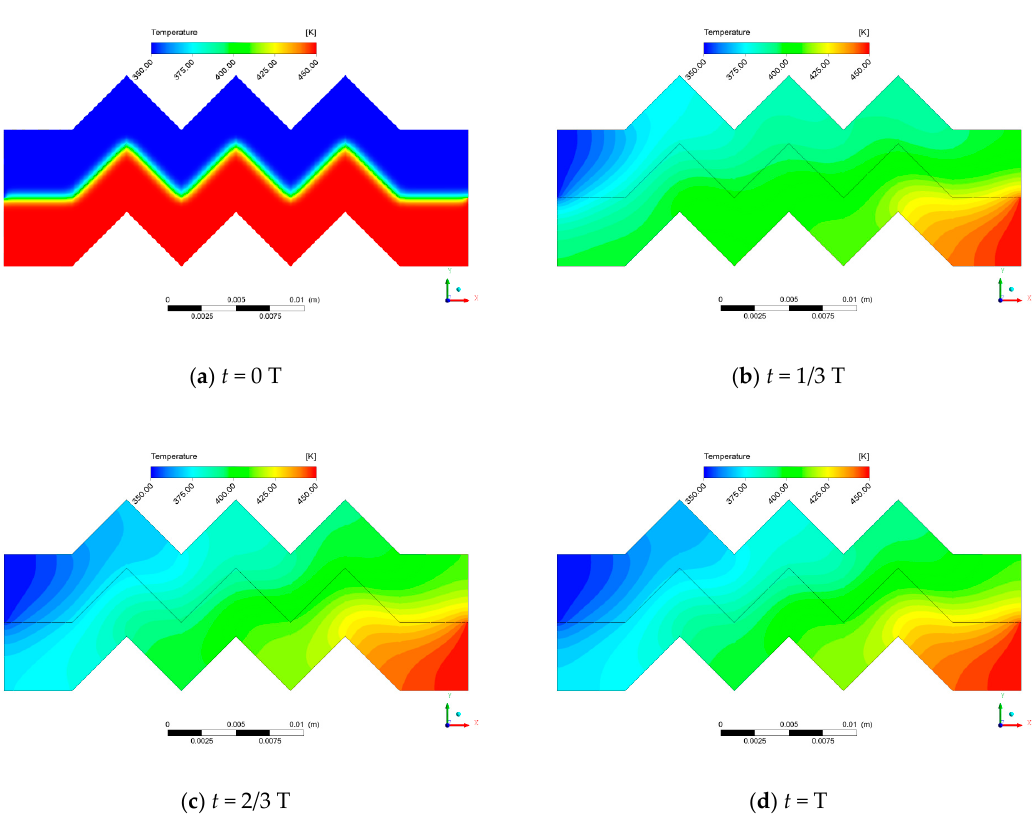
Figure 5. Temperature distribution at different time.